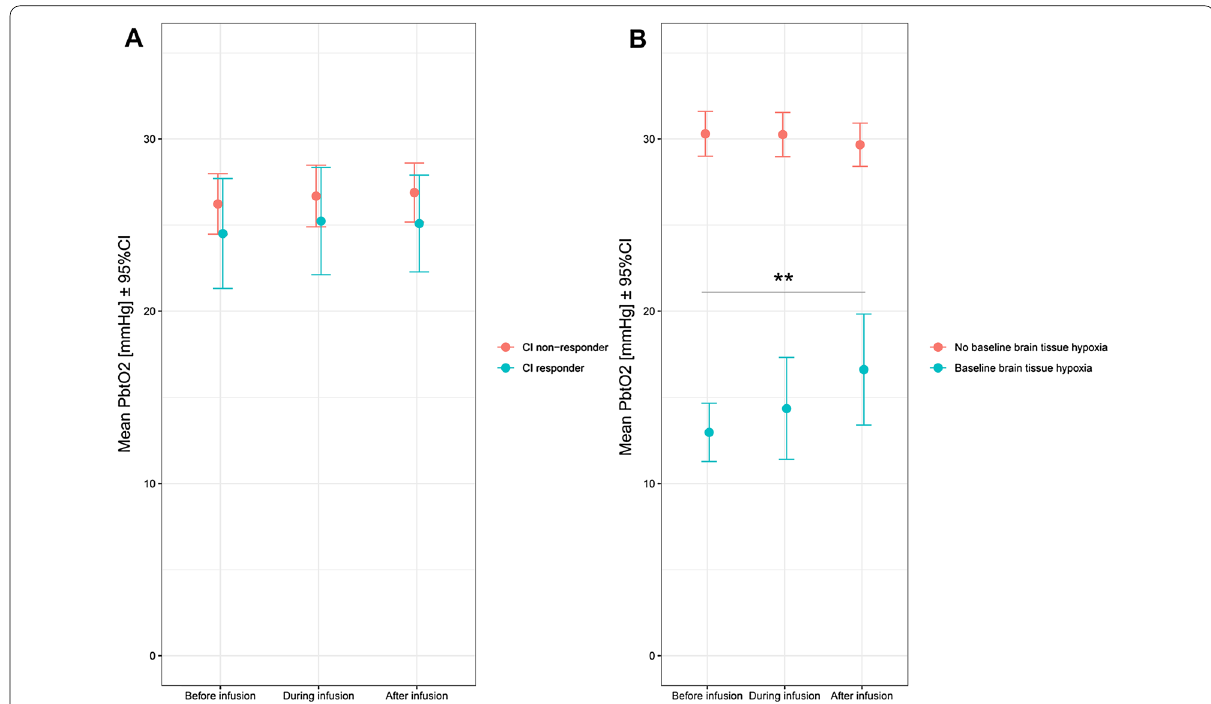
Fig. 5 A P bt O 2 did not change ( p increased as a response to fluid boluses in the setting of baseline brain tissue hypoxia ( p